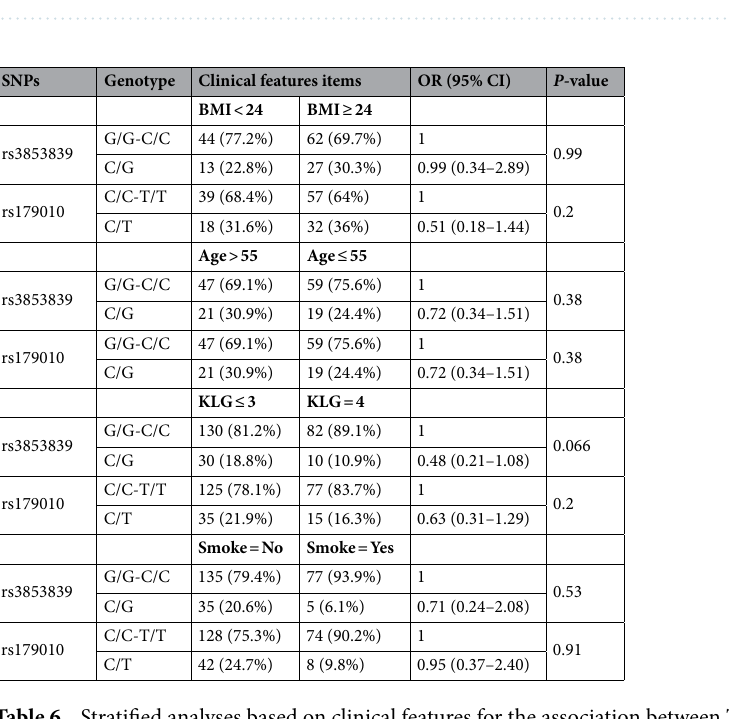
Table 6. Stratified analyses based on clinical features for the association between TLR7 polymorphism and the risk of Knee OA. Knee OA osteoarthritis patients group, HC healthy control group, OR Odds ratios, CI confidence intervals, KLG Kellgren-Lawrence grade, BMI Body Mass Index. The data adjusted by moke + drinking + age + BMI.